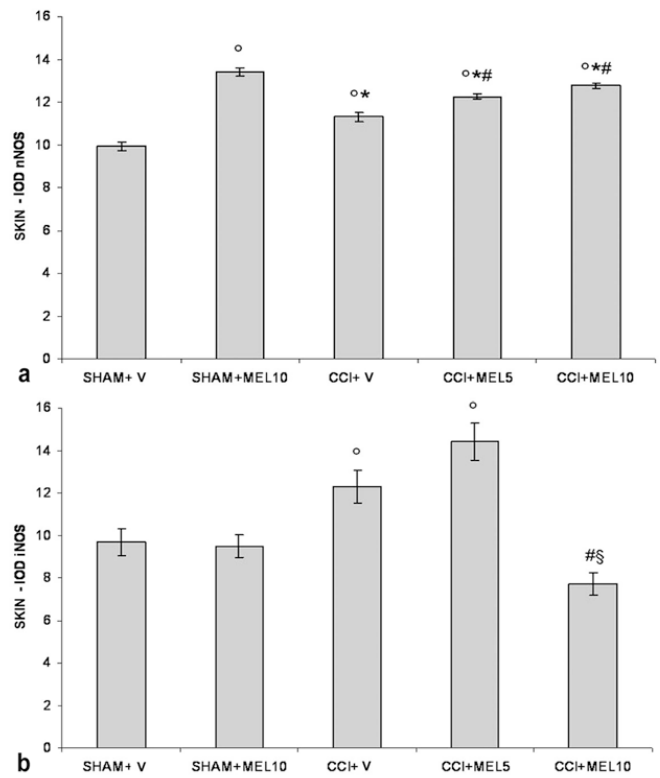
Figure 5. nNOS and iNOS evaluation in plantar skin. ( a ) Quantitative evaluation of nNOS immunopositivity in the epidermis of the right hind-paw plantar skin as IOD (integrated optical density) in the experimental animals: sham-operated rats treated with 1% ethanol in saline (vehicle for melatonin) (SHAM + V); sham-operated rats treated with melatonin 10 mg/kg (SHAM + MEL10); CCI rats treated with 1% ethanol in saline (vehicle for melatonin) (CCI + V); CCI rats treated with melatonin (5 mg/kg) (CCI + MEL5); CCI rats treated with melatonin (10 mg/kg) (CCI + MEL10). Data represent means ± SEM, ◦ p < 0.05 vs. SHAM + V, * p < 0.05 vs. SHAM + MEL10, # p < 0.05 vs. CCI + V. ( b ) Quantitative evaluation of iNOS immunopositivity in the epidermis of the right hind-paw plantar skin as IOD (integrated optical density) in the experimental animals: sham-operated rats treated with 1% ethanol in saline (vehicle for melatonin) (SHAM + V); sham-operated rats treated with melatonin 10 mg/kg (SHAM + MEL10); CCI rats treated with 1% ethanol in saline (vehicle for melatonin) (CCI + V); CCI rats treated with melatonin (5 mg/kg) (CCI + MEL5); CCI rats treated with melatonin (10 mg/kg) (CCI + MEL10). Data represent means ± SEM, ◦ p < 0.05 vs. SHAM + V, # p < 0.05 vs. CCI + V, § p < 0.05 vs. CCI +